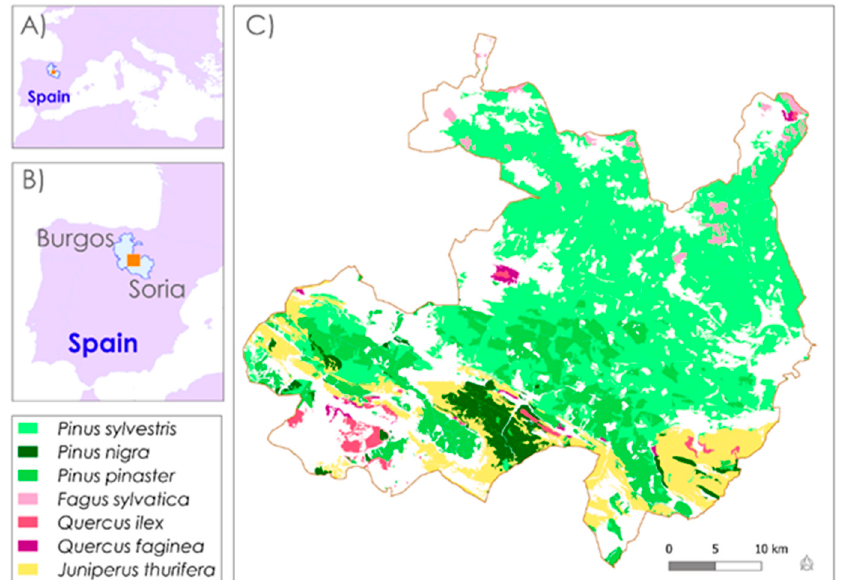
Figure 1. ( A ) Location of the study area in the Mediterranean basin, in the Spanish provinces of Burgos and Soria ( B ), and ( C ) main forest species distribution in the Urbión Model Forest, according to the Spanish National Forest Map.